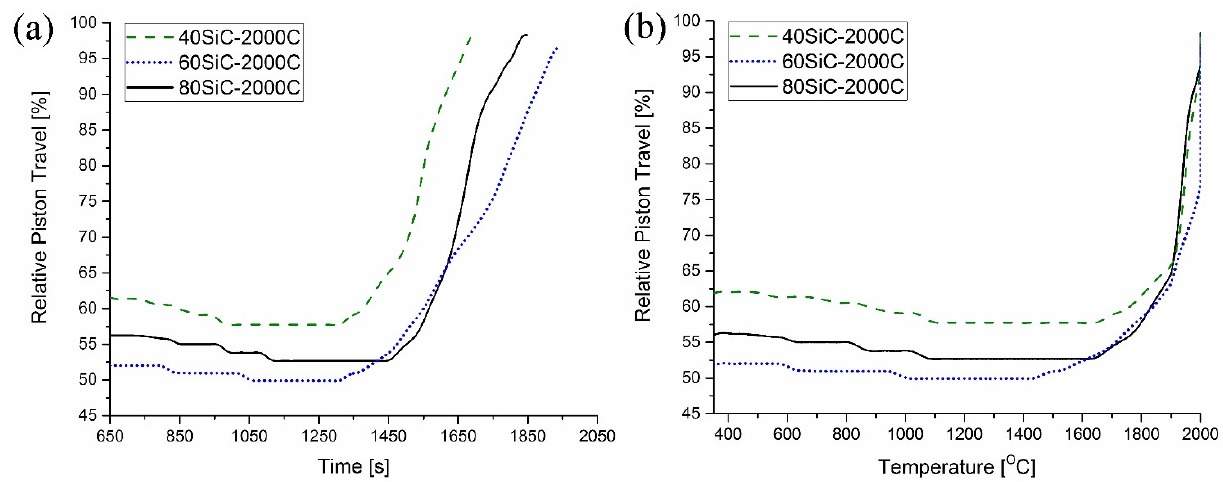
Figure 8. Relative piston travel vs. ( a ) time and ( b ) temperature of 80SiC, 60SiC, and 40SiC composites. Table 4. Possible chemical reactions during the sintering of the SiC-TiB 2 -TiC